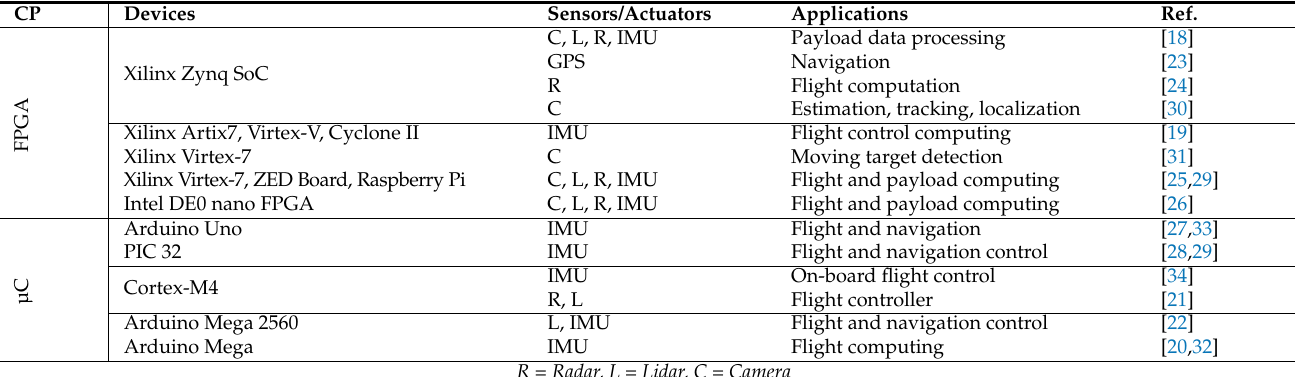
Table 2. List of research works and their implemented FCC